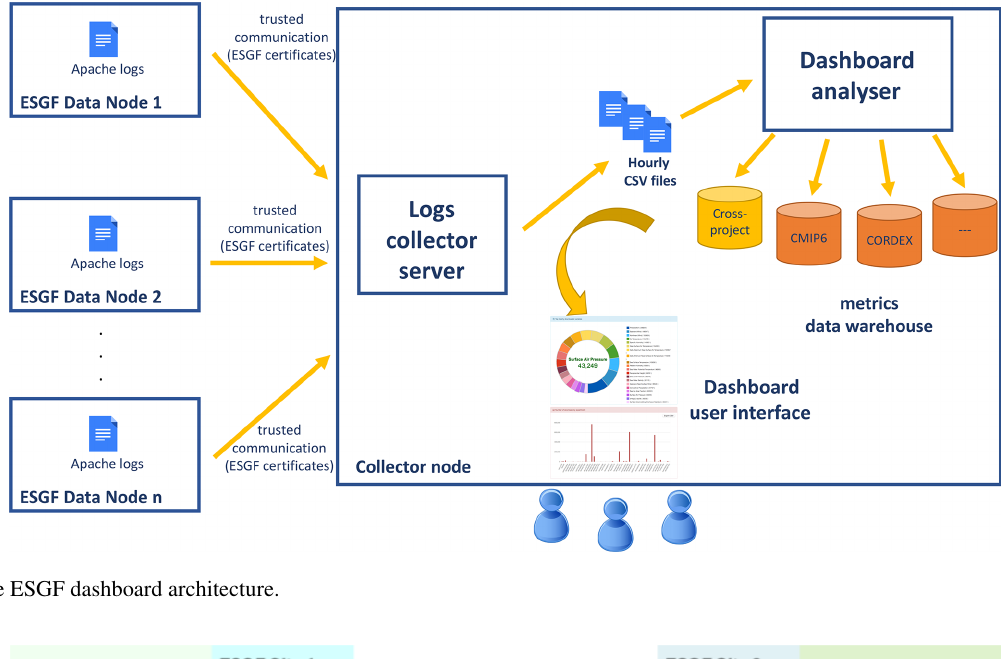
Figure 5. The ESGF dashboard architecture.